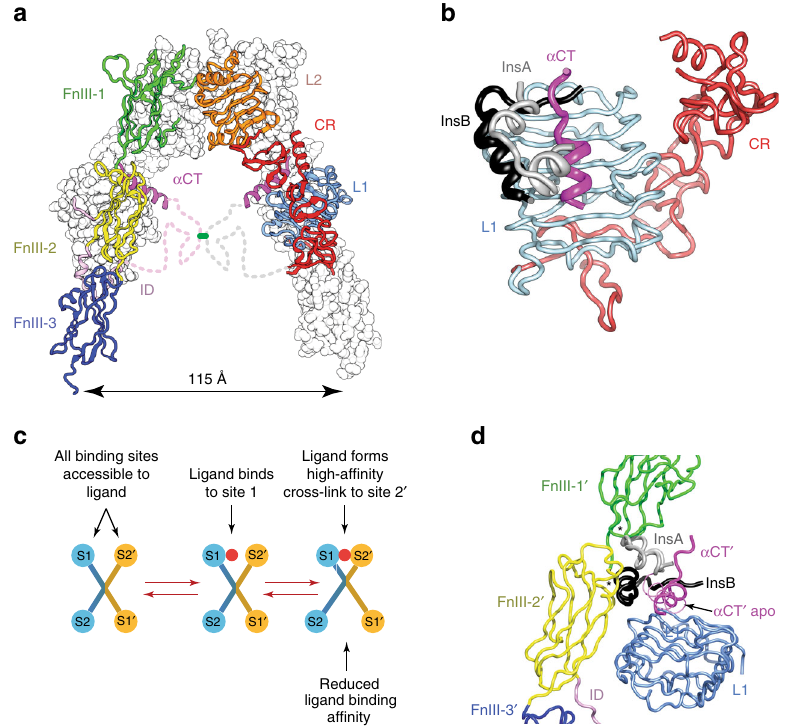
Fig. 1 Structural biology of apo IR Δβ and insulin-bound μ IR and the current model of ligand binding kinetics. a The Λ -shaped assembly of IR Δβ (PDB entry 4ZXB) 8 . Domain colours are L1 light blue, CR red, L2 orange, FnIII-1 green, FnIII-2 yellow, FnIII-3 dark blue, ID light magenta, α CT magenta. The foreground monomer is in ribbon representation, the background monomer in surface representation (apart from the ID element); dashed lines indicate disordered residues within the respective ID segments. b Human insulin (A chain grey, B chain black) bound to μ IR (PDB entry 4OGA) 11 , coloured as in a . c Major pathway of ligand binding to IR and IGF-1R within the current kinetic model. S1, S2: site 1 and site 2 on one receptor monomer; S1 ΄ , S2 ΄ : site 1 and site 2 on the opposing receptor monomer. Red fi lled circle: ligand (i.e., IGF-I, IGF-II or insulin). d Steric overlap (asterisked) between insulin and the opposing fi bronectin domain module of the structures depicted in a and b based on overlay of their common domain L1. α CT ΄ is shown in both its apo conformation (thin magenta ribbon) and its insulin-complexed conformation (magenta ribbon) in order to illustrate its altered disposition upon insulin